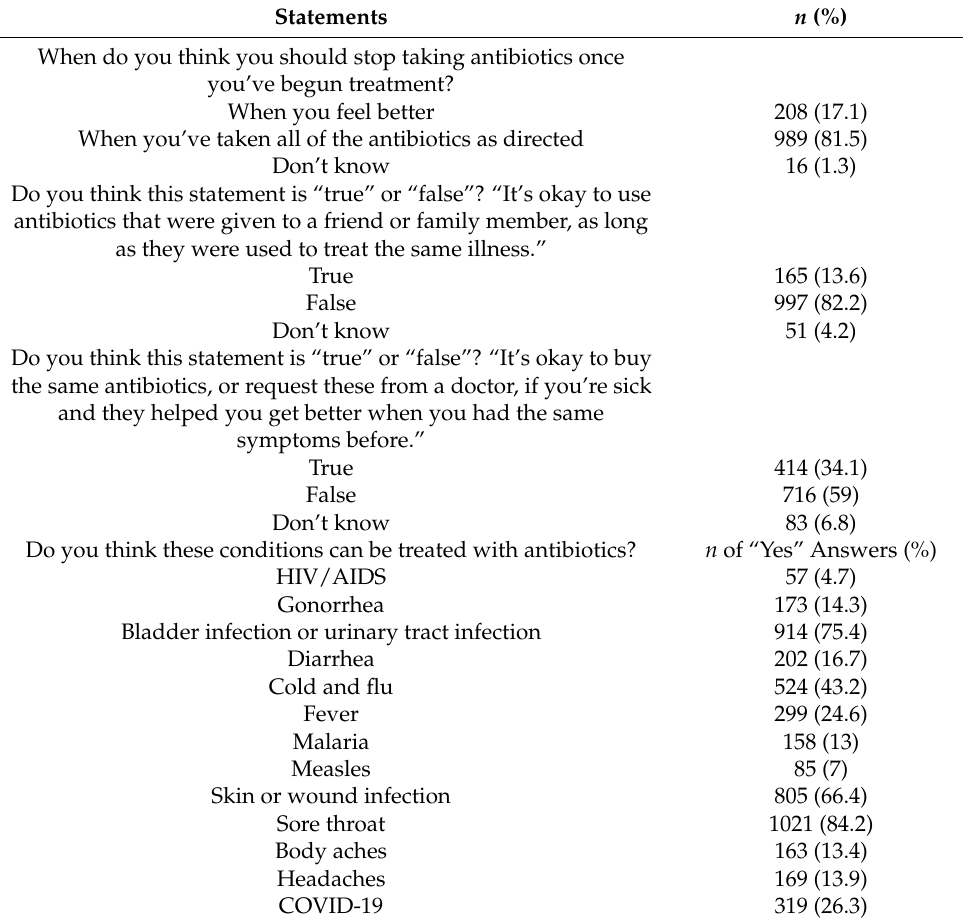
Table 2. Knowledge of antibiotic use among